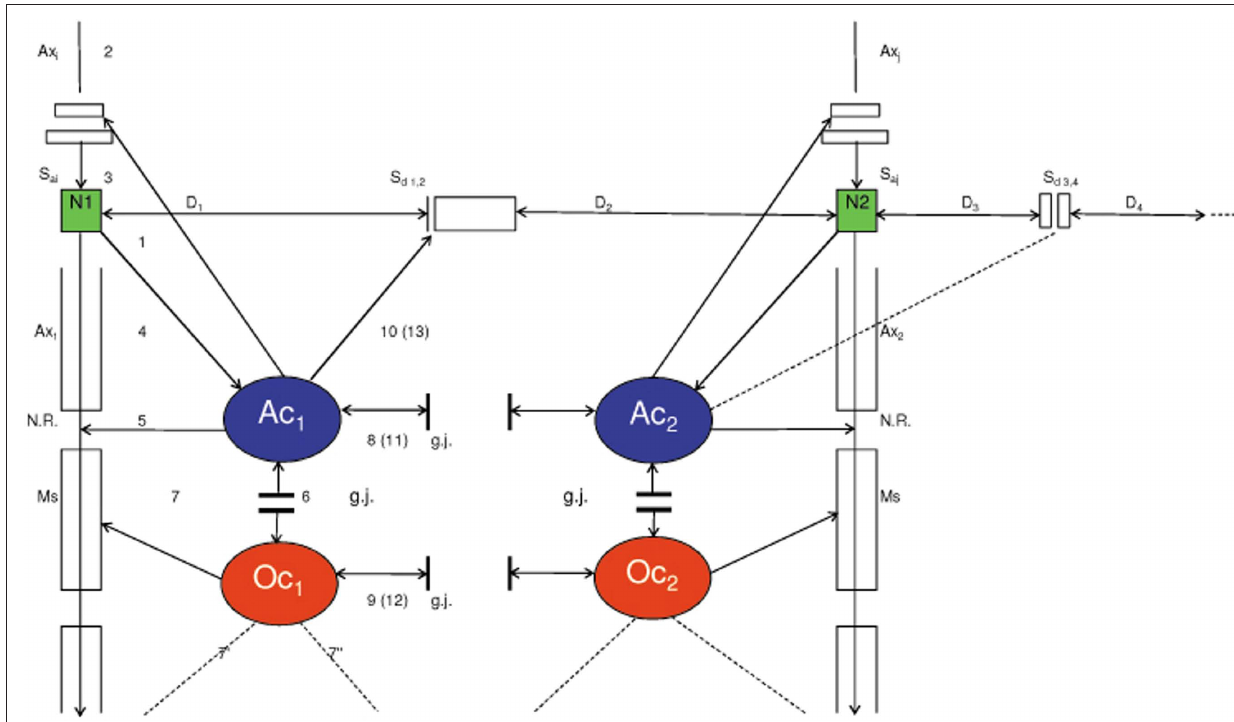
oligodendrocytes. The neuronal system shows two neurons (N afferent axons (Ax ) and two afferent axodendritic synapses (Sa i, j axons (Ax ) with myelin sheaths (Ms) and a node of Ranvier (N.R.), as well as 1, 2 two dendro-dendritic synapses (Sd ) ) with the corresponding dendrites (D 1, 2 1, 2¸3, 4 D , D , D 2 3 4